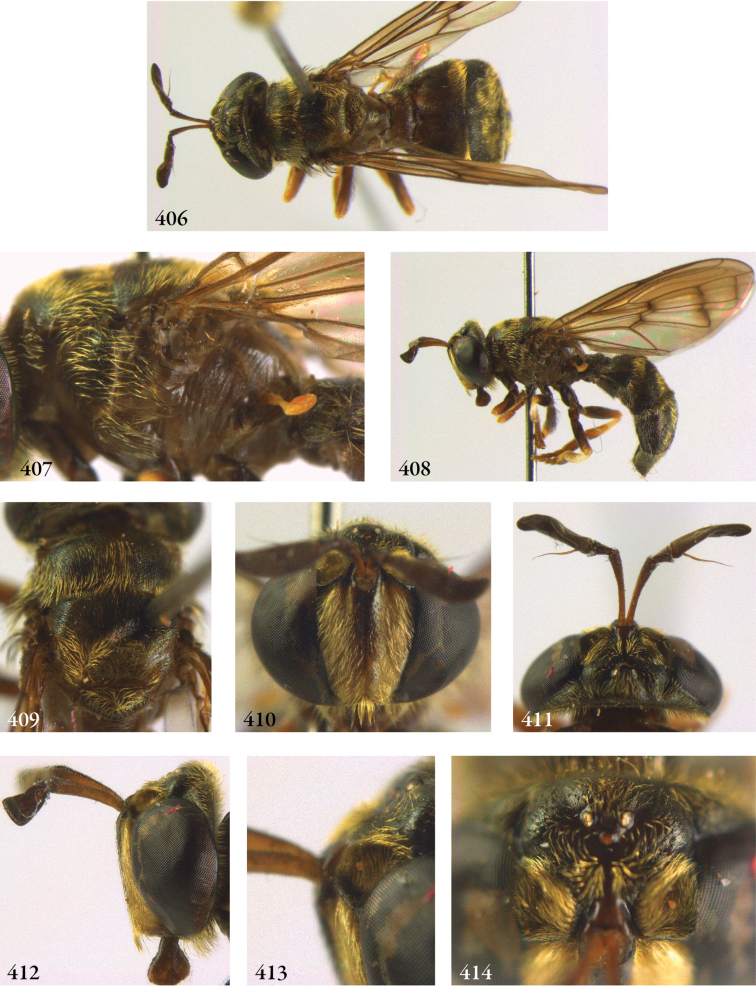
406–411
Thompsodon conspicillifrons female (holotype): 406 habitus dorsal 407 thorax lateral 408 habitus lateral 409 thorax dorsal 410 head frontal 411 head dorsal 412–414
Thompsodon conspicillifrons female (holotype): 412 head lateral 413 frons lateral 414 frons frontal.